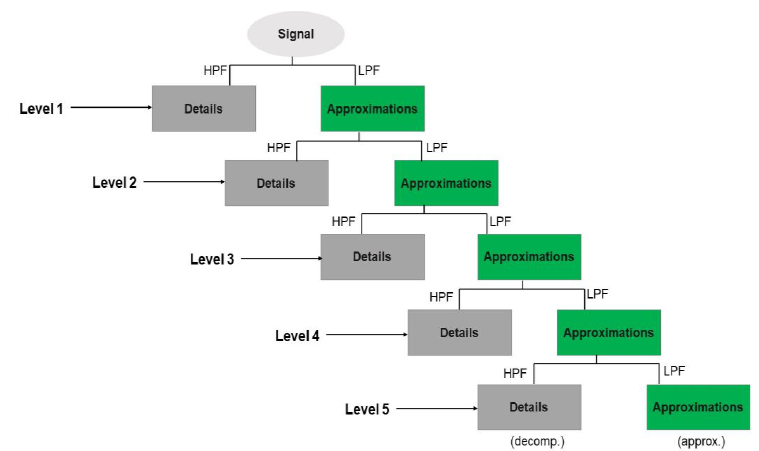
Figure A1. Feature creation using wavelet decomposition.